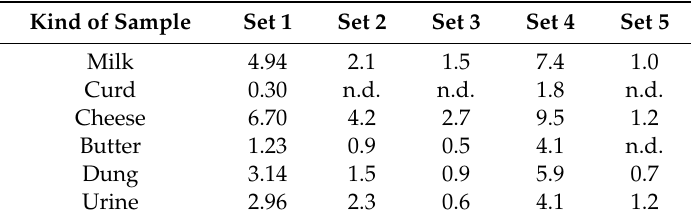
Table 3. Concentration of MBZ (ppm) found in di ff erent incurred samples. Kind of Sample Set 1 Set 2 Set